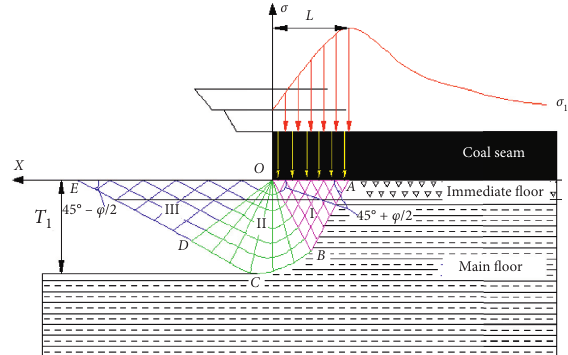
Figure 3: Failure model of the 7# coal seam floor.